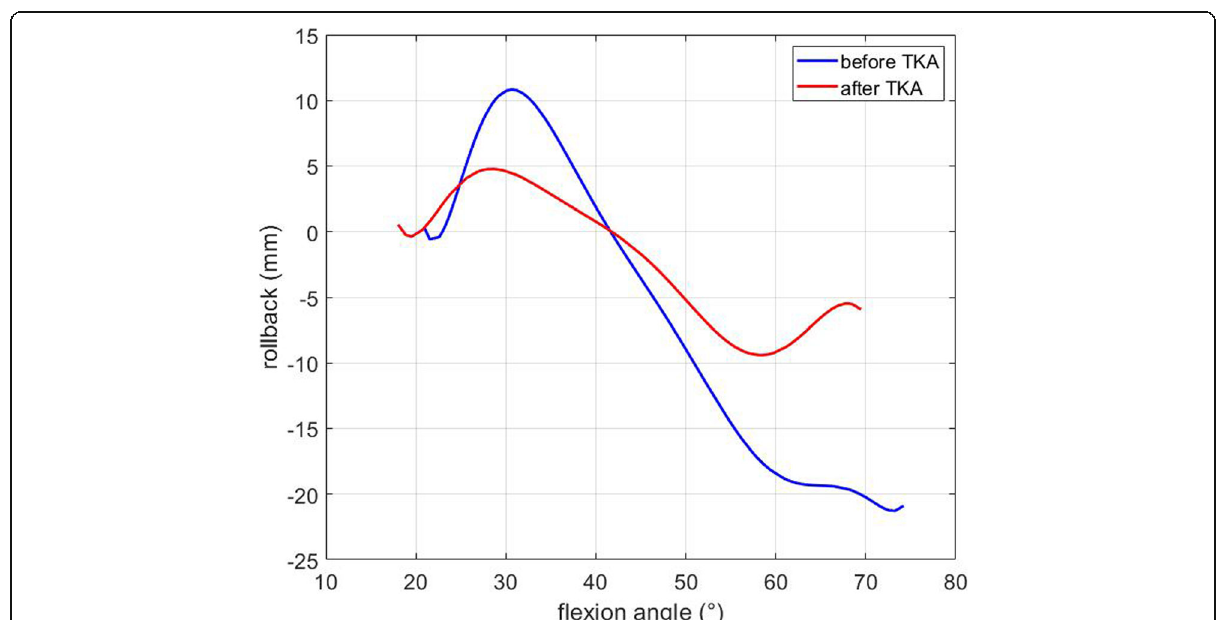
Fig. 11 Interpolation of the measured displacement of the contact point between femur and tibia, or rollback, along the horizontal